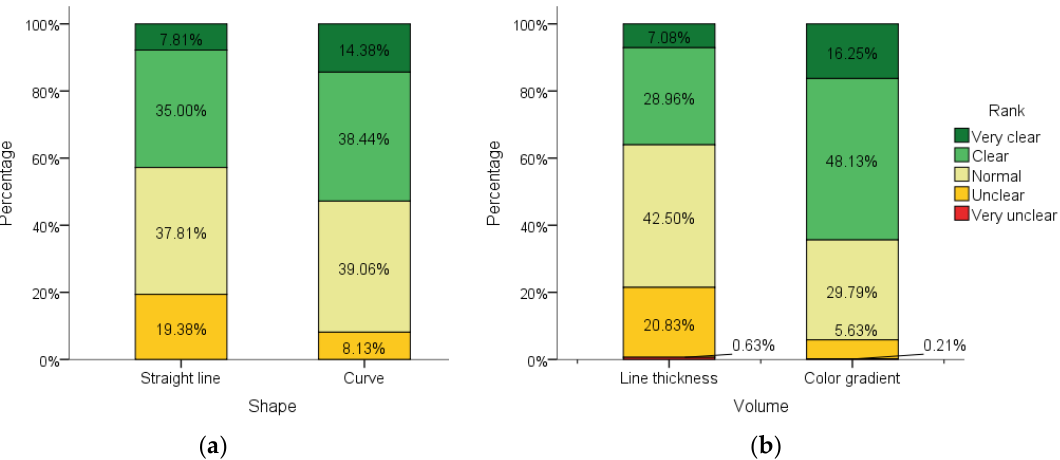
Figure 5. Statistics for questionnaires ( SL = straight line, CV = curve, LT = line thickness, and CG = color gradient). ( a ) Line shape and ( b ) flow volume.